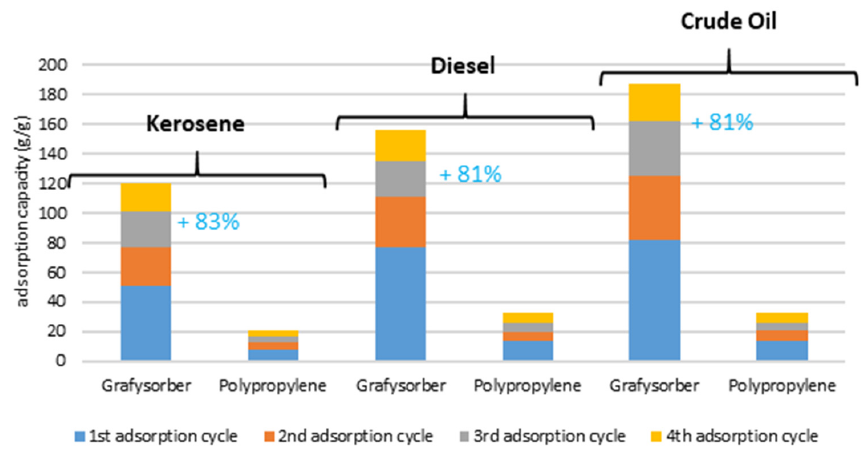
Figure 12. Cumulative adsorption capacity, after 3 regeneration cycles (4 uses).